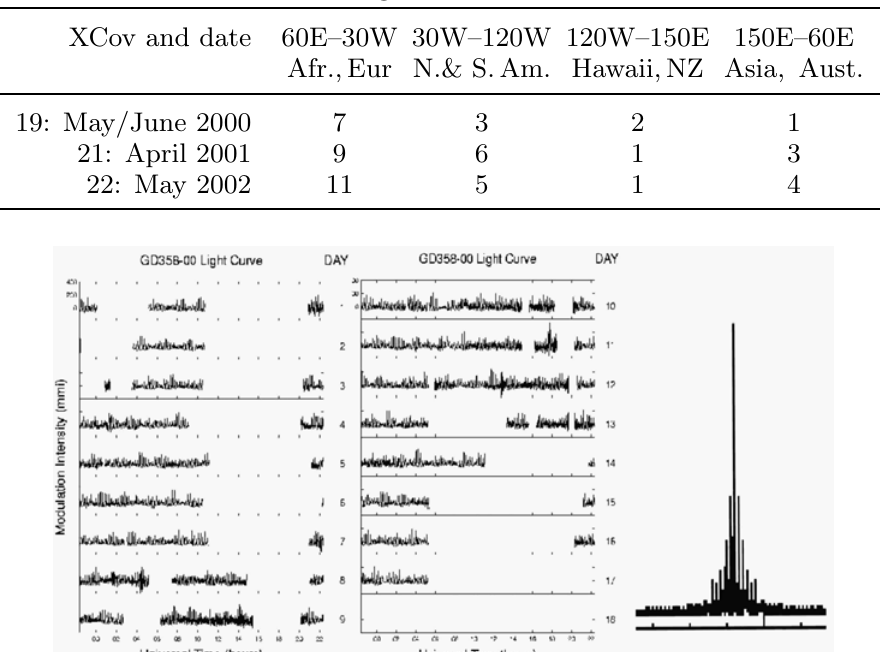
Table 1. Number of participating telescopes in recent XCov’s distributed in longitude.